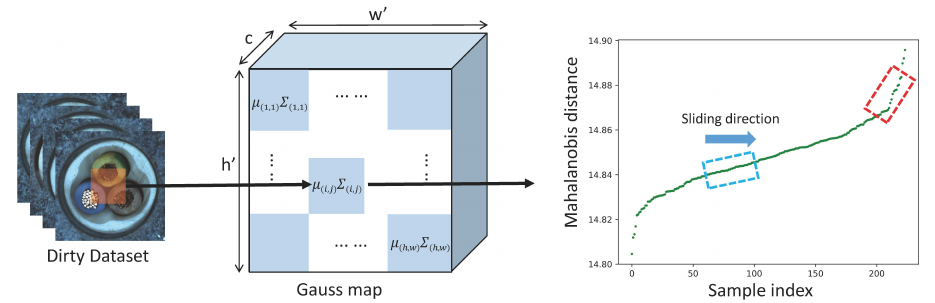
Figure 4. At position ( i , j ) , a Gaussian distribution is fitted with the patch feature vector of all samples. The dashed box represents the sliding window and the red dashed box represents the target